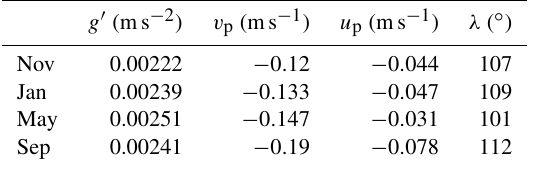
Table 1. Boundary current parameters and variables obtained from the numerical simulations on the sill based on transect I (see